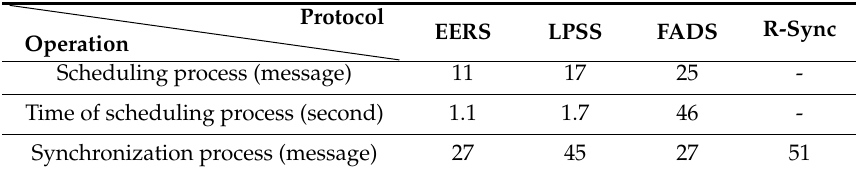
Table 2. Comparison of EERS, LPSS, FADS and